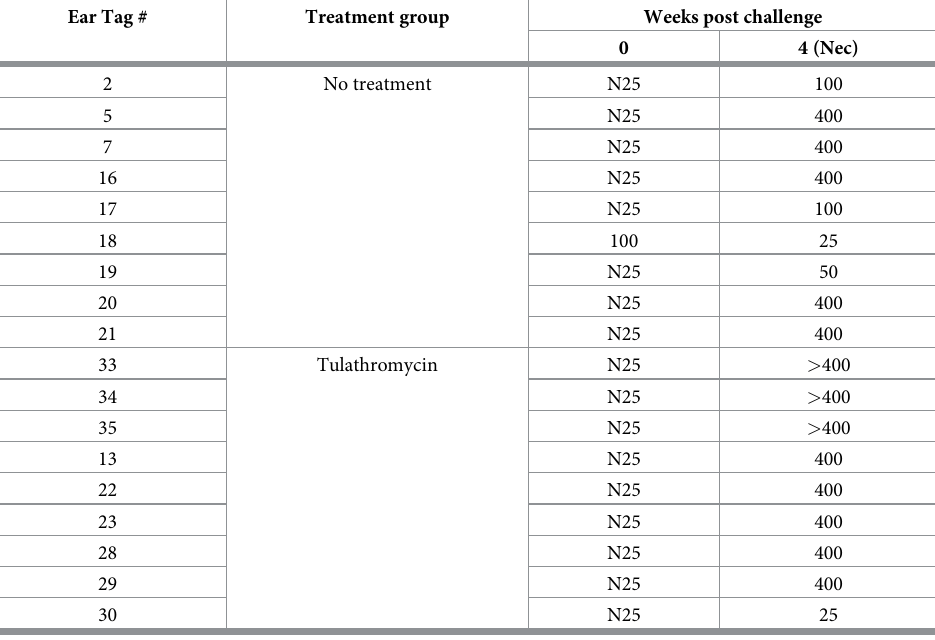
Values are indictive of the highest dilution performed at which animals were positive.